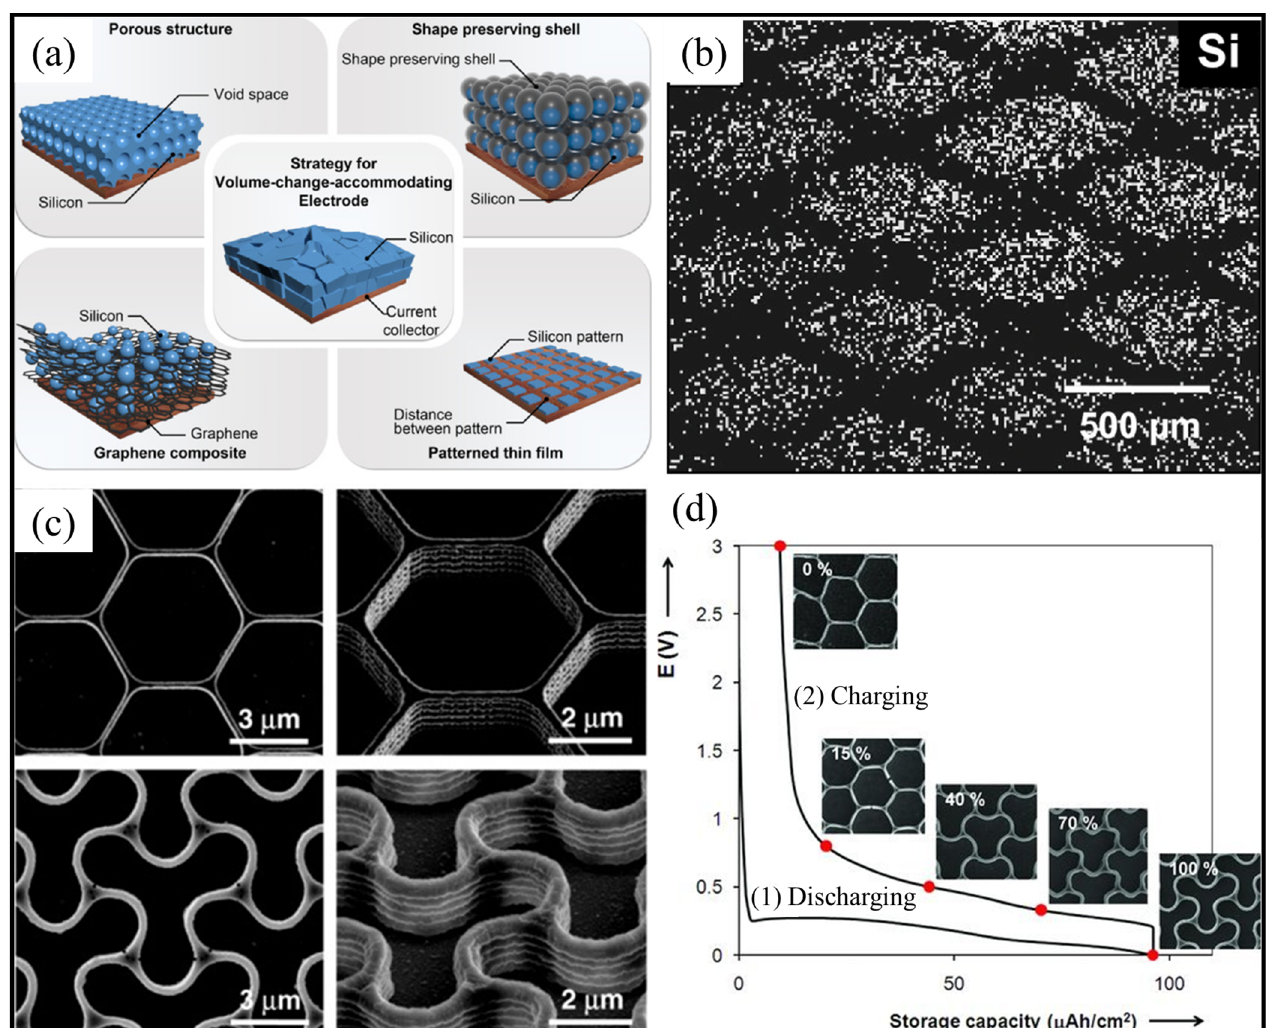
Figure 5. ( a ) Representative strategies for volume-change-accommodating Si electrode [117], ( b ) SEM photographs of patterned Si film electrodes [118], ( c ) SEM top and tilted view photographs of as-prepared (top) and fully lithiated silicon honeycomb structure (bottom). ( d ) Morphological changes of the Si honeycomb structure as a function of Li-content [119].